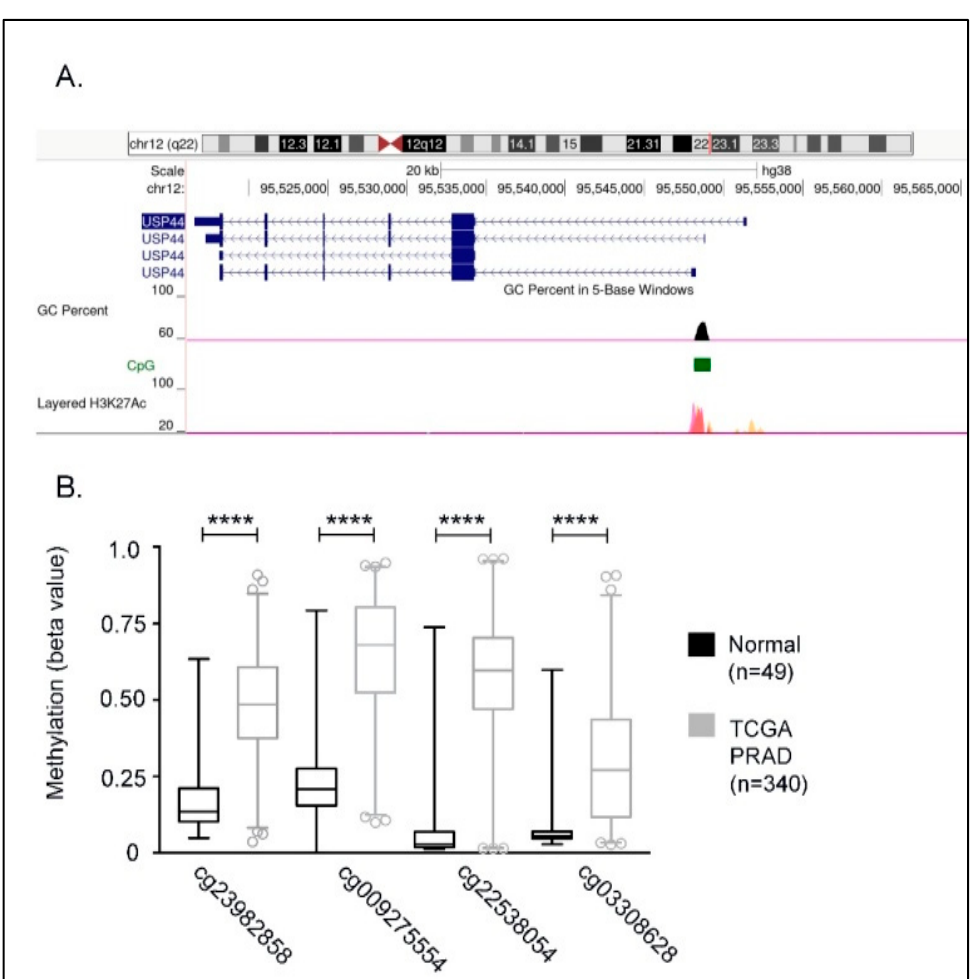
Figure 1. USP44 promoter methylation. ( A ) Structure of USP44 gene isoforms by ENCODE genome viewer. Promoter regions with high CpG context (black peaks) is indicated with green color. Tran- scriptional start site is indicated by peaks of H3K27Ac histone marks according to ENCODE data. ( B ) Cytosine sites within the indicated CpG island that display significant methylation in prostate adenocarcinoma samples as compared to normal samples. Methylation data were obtained from TCGA Wanderer database and Mann-Whitney test was used to analyze methylation levels between cancerous and normal samples. p values < 0.0001 are indicated with four asterisks (**** indicates p<0.0001 ).